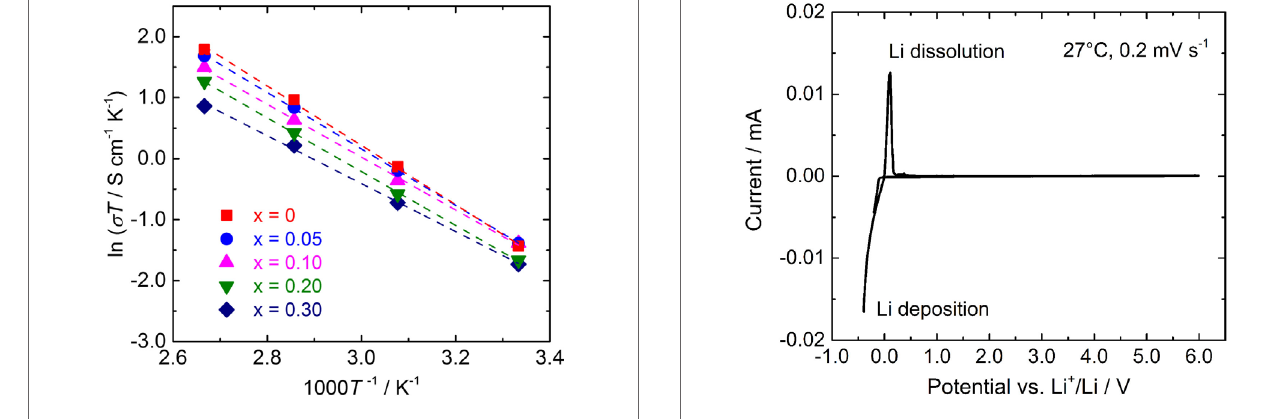
FigUre 8 | arrhenius plot of the conductivity σ for llBZT with different Ba contents x = 0–0.30 plotted against the inverse of measurement temperature .